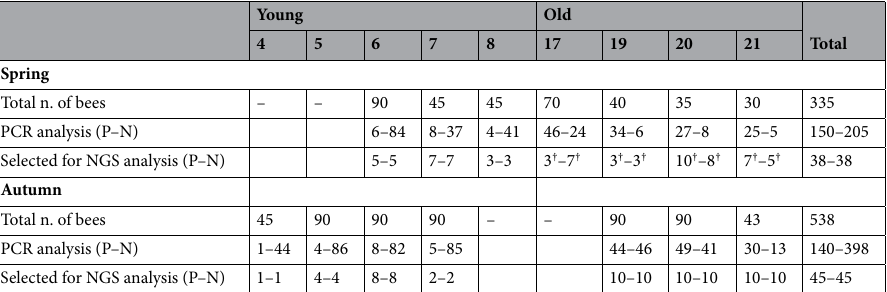
Table 1. Honeybees analyzed in this study. Includes the total number of samples collected and analyzed by PCR to detect N. ceranae each day and the results (P—positive and N—negative). It also includes the number of samples selected for the next generation sequencing (NGS) analysis in each sample set, which are infected (P) and non-infected (N) bees in the group of young and old bees (with the age expressed in days) from both seasons, spring and autumn. The numbers correspond to anterior section samples analyzed. † In old adult bees from spring, the posterior section from the samples was analyzed as